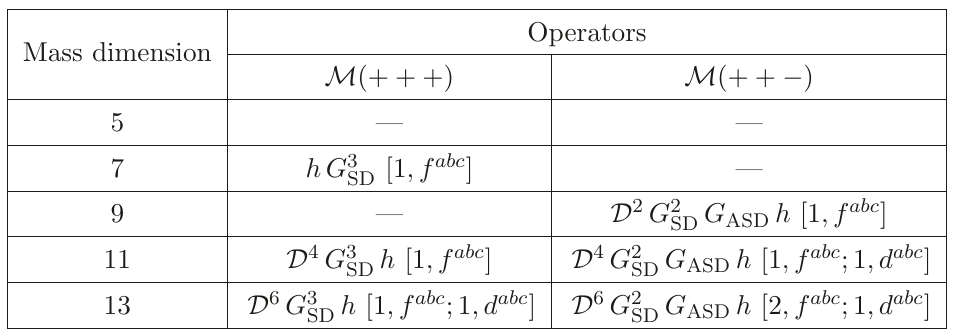
Table 1. Operators contributing to the h of each type and color structure appears in